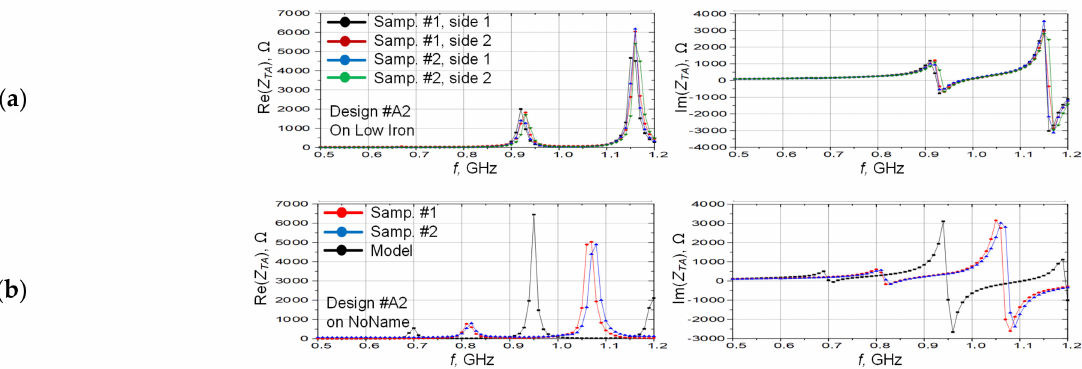
Figure 8. Impedance of RFID antenna: ( a ) Design #A2 on both sides of low-iron glass; ( b ) Design #A2 on NoName